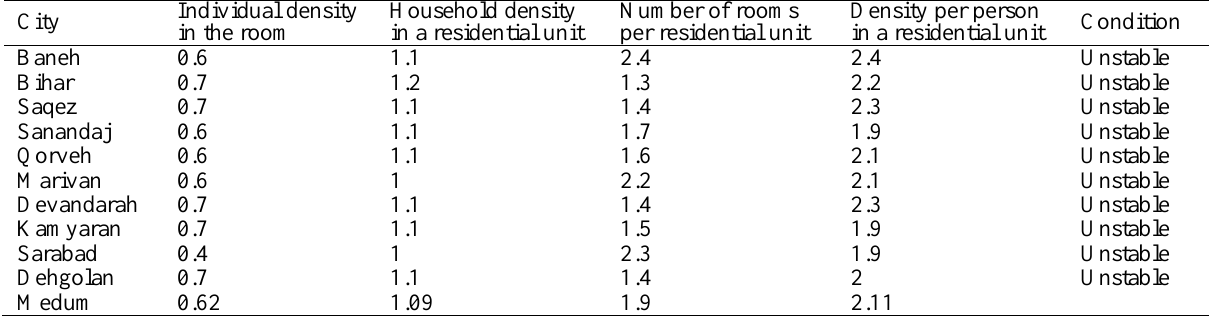
Table 4. Density index units in rural housing units of Kurdistan province (2011); source: research findings/statistical yearbook) Individual density City in the